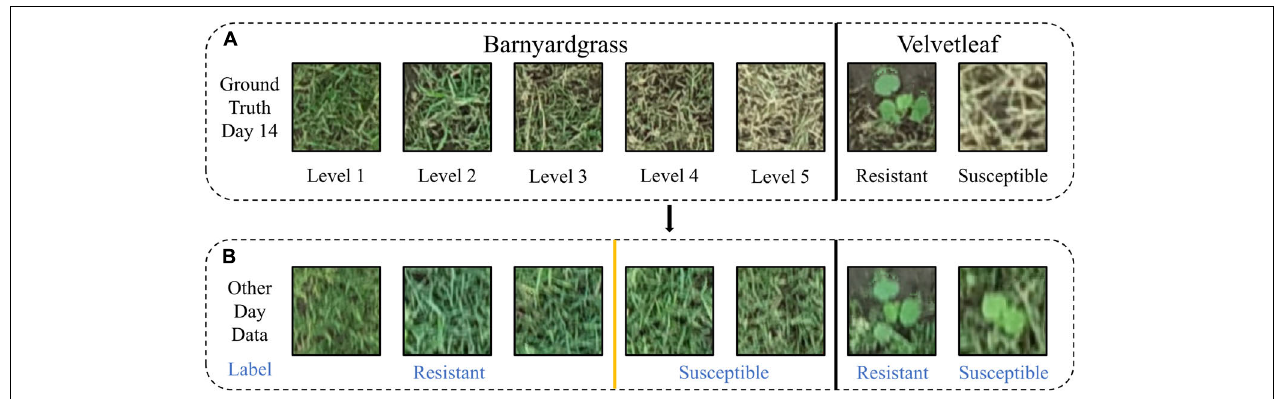
FIGURE 4 | Two weeds belonging to blocks were evaluated as susceptible and resistant. (A) Manual resistance level and label based on weed death coverage 14 days after atrazine application. (B) Visualization of the data labels on other days.